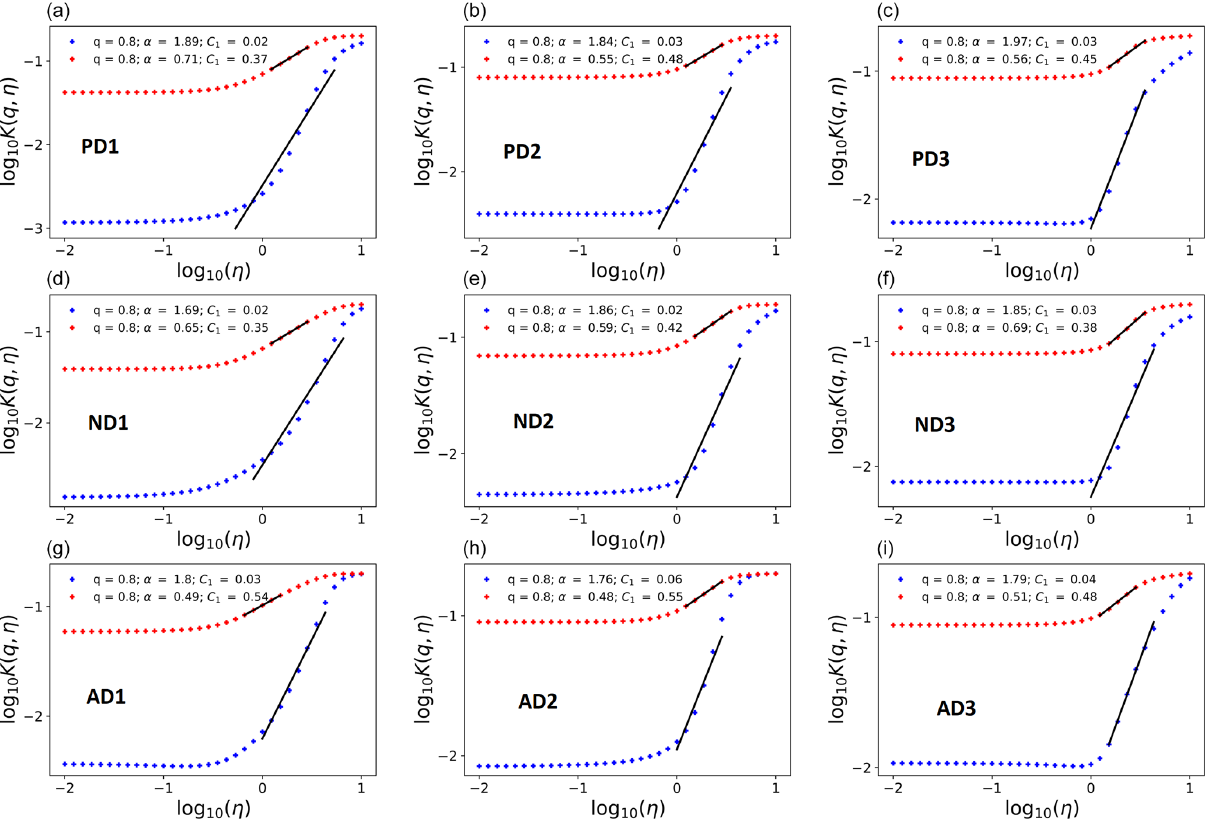
Figure 4. Double trace moment analysis of accumulated rainfall data to obtain UM parameter estimates. (a, b, c) Paris: PD1, PD2, PD3; (d, e, f) Nantes: ND1, ND2, ND3; (g, h, i) Aix: AD1, AD2, AD3. The first scaling regime is shown in blue, whereas the second scaling regime is shown in